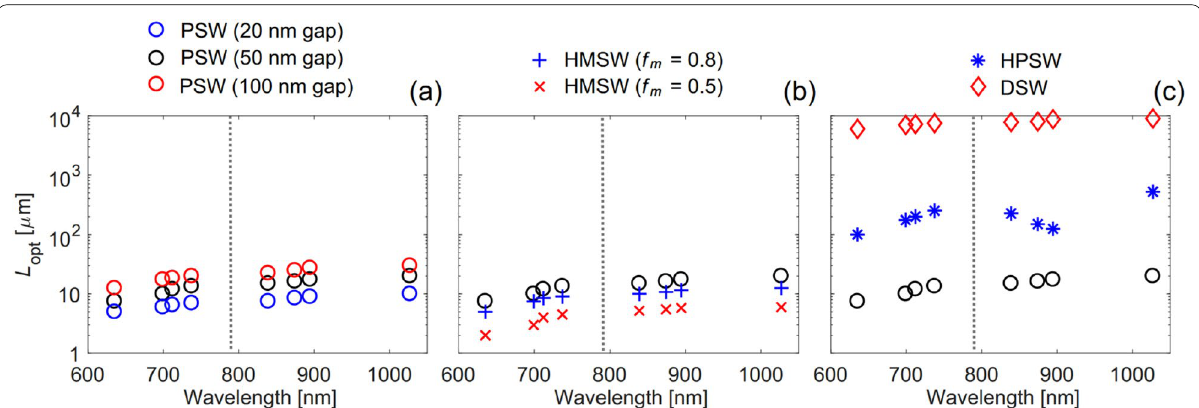
Fig. 6 Optimized WG length L opt for maximum spatially averaged Raman enhancement factor (AEF) for the case of forward scattered signal collection, as a function of wavelength for the Ag plasmonic slot WG (PSW) with gap width g 50 nm, and other WGs obtained by a varying = 0.8 the gap width g: Ag PSW with gap width g 100 and 20 nm, b varying the metal filling fraction f m : Ag-Si 3 N 4 HM slot WG (HMSW) with f m = = and 0 0.5, and c changing the WG type: Ag-Si 3 N 4 hybrid plasmonic slot WG (HPSW) and Si 3 N 4 dielectric slot WG (DSW). Each marker indicates a specific Stokes or anti-Stokes wavelength corresponding to one of the Raman modes. The vertical dotted line indicates the pump wavelength at λ 0 785 nm. (Reprinted with permission from Ref. =